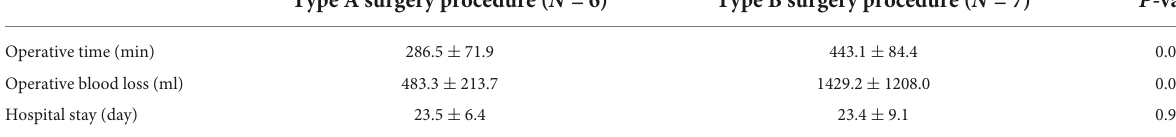
TABLE 3 Comparison of operation data between Type A and Type B